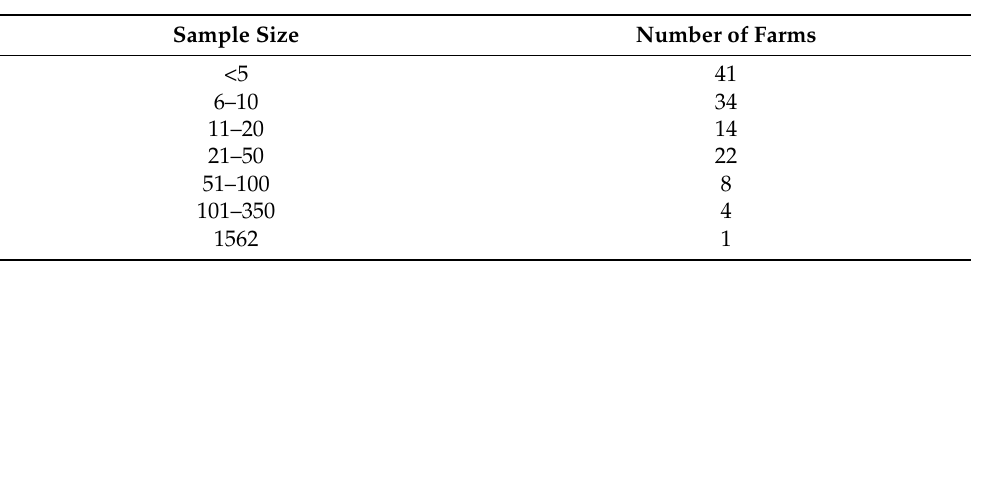
Table 1. Summary of the number of Hanwoo cattle sampled per